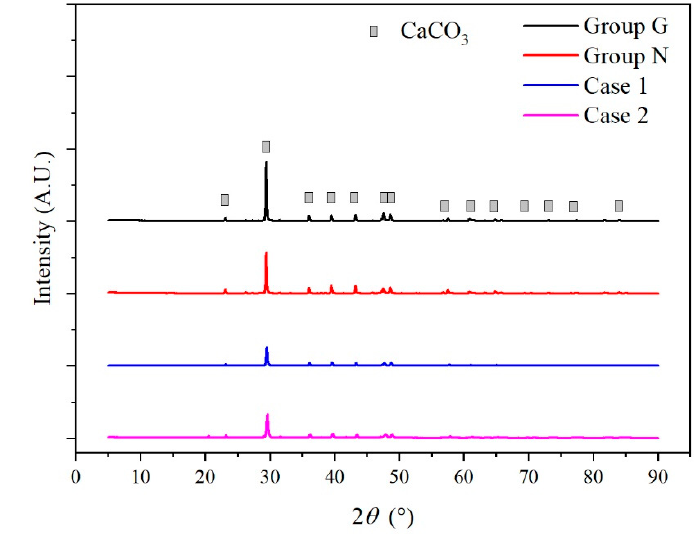
Figure 6. Crystal structure of the inorganic precipitates.